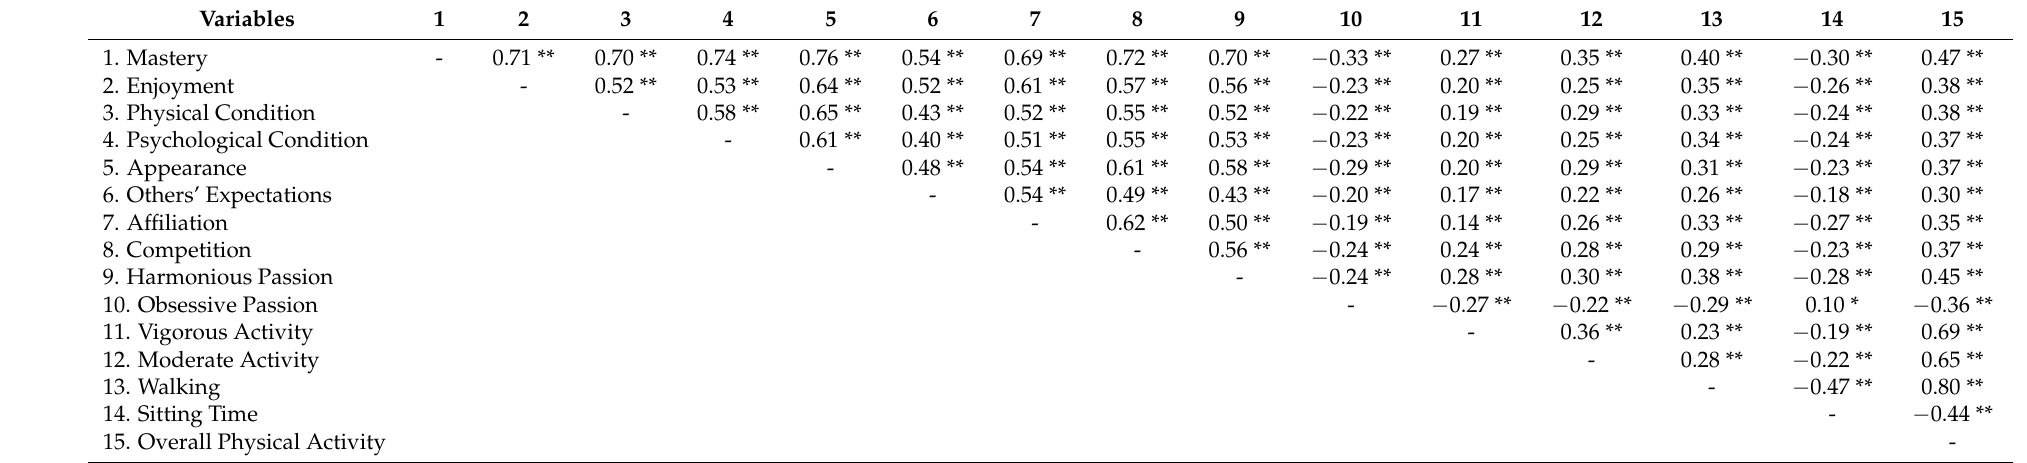
Table 1. Correlations among PALMS, Passion Scale and Physical Activity Subscales ( N =